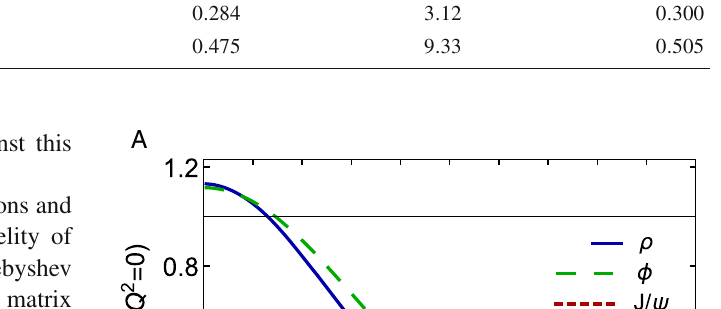
both continuum and lattice analyses, e.g., Ref.[69]. For comparison, where known, empirical values are [61]: m π = 0 . 138, m η s ¯ s